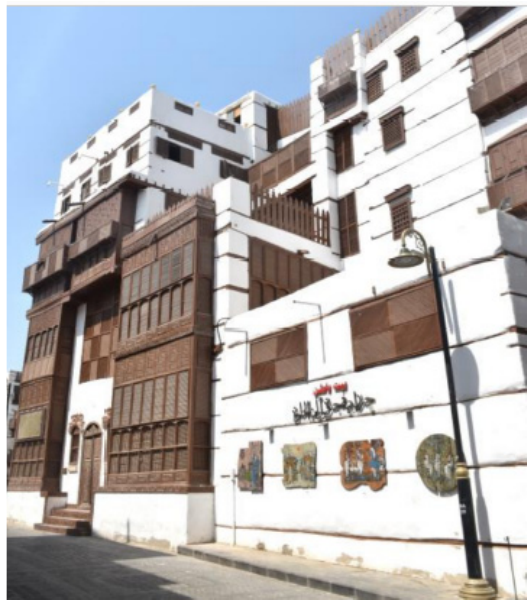
Figure 2. Case-study building.